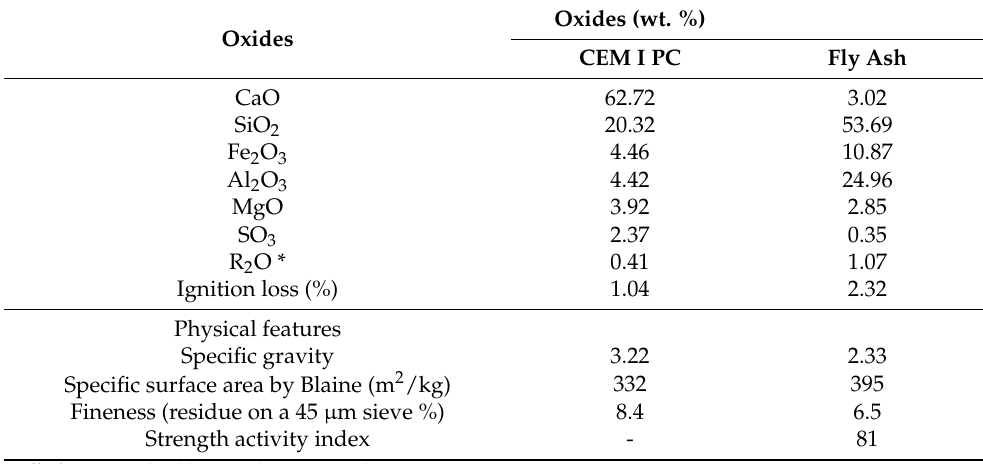
Table 1. Physical features and oxides of the cement and fly ash.